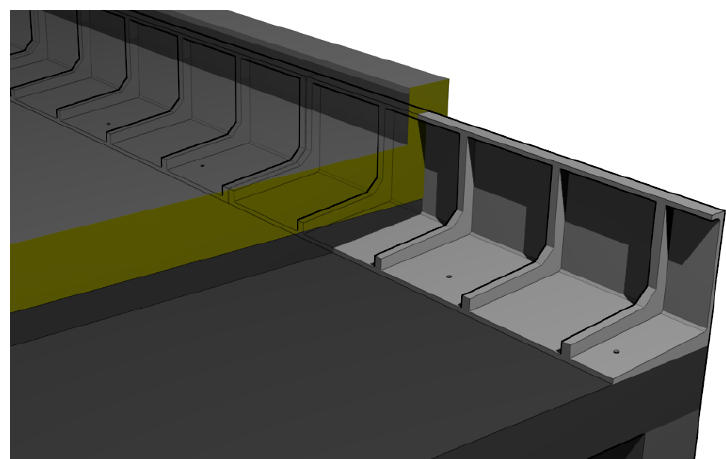
Figure 2. Installation of special shaped parapet block on the building (simplified visualization).